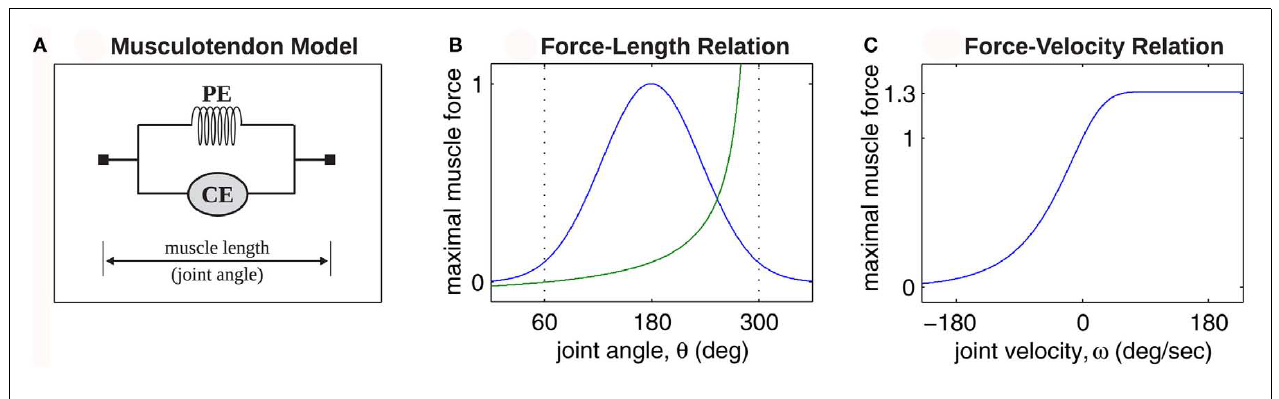
(B) Force-length relationships for CE (blue line) with θ min = 60˚, θ 0 = 180˚, θ = 300˚, k =− ( θ − θ max l max 0 ) 2 /ln(0.1), and PE (green line) with k pe Vertical axis is normalized with respect to F max . (C) Force-velocity relationship for CE with k v = 1. Maximal muscle force asymptotes at 1.313